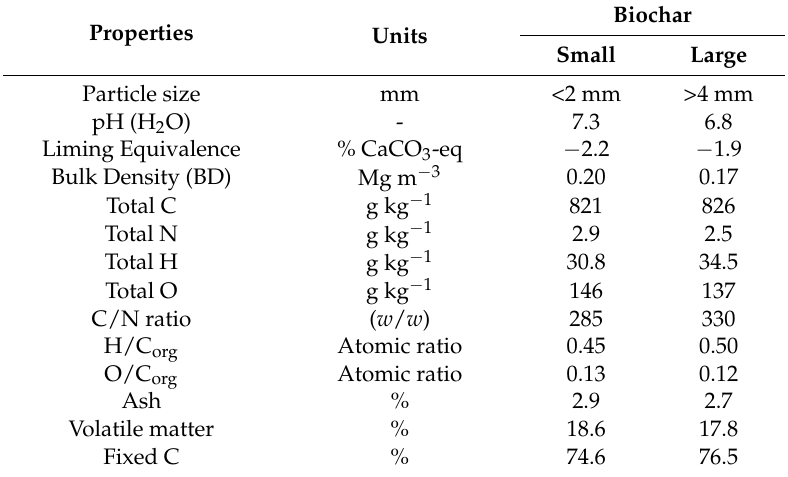
Table 1. Chemical characteristics of pine biochar (feedstock source: Foxton, New Zealand) at the beginning of